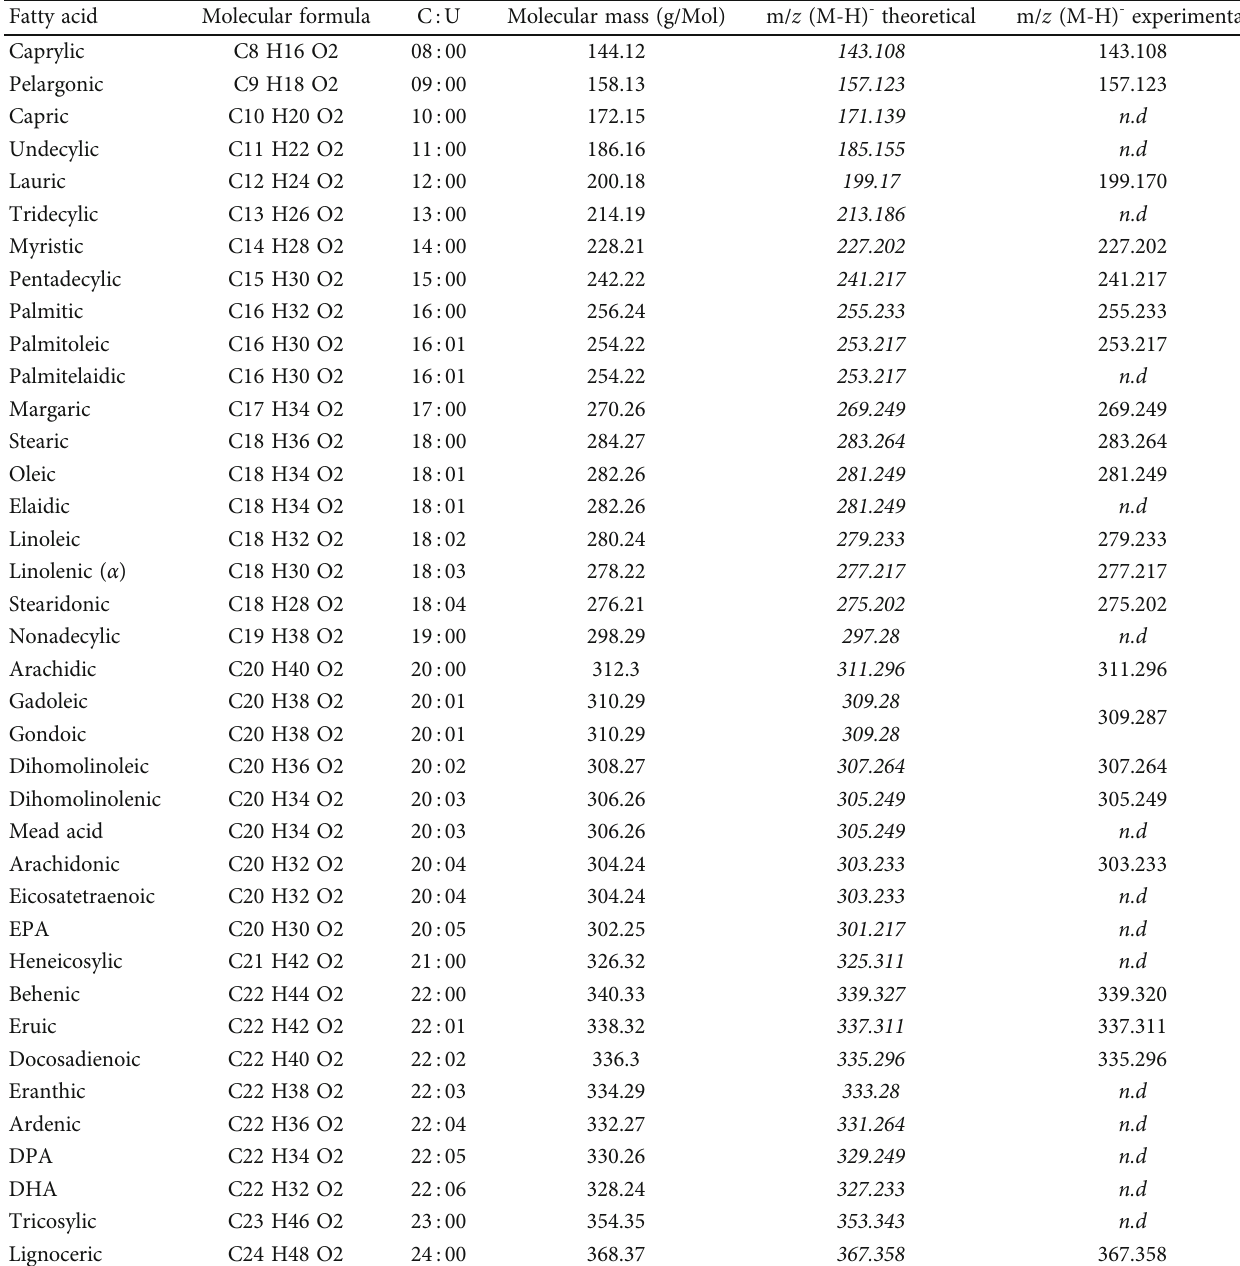
Table 1: Database of fatty acid information used to analyse chromatograms. The theoretical m/ z of individual fatty acids and the experimental m/ z detected of the individual fatty